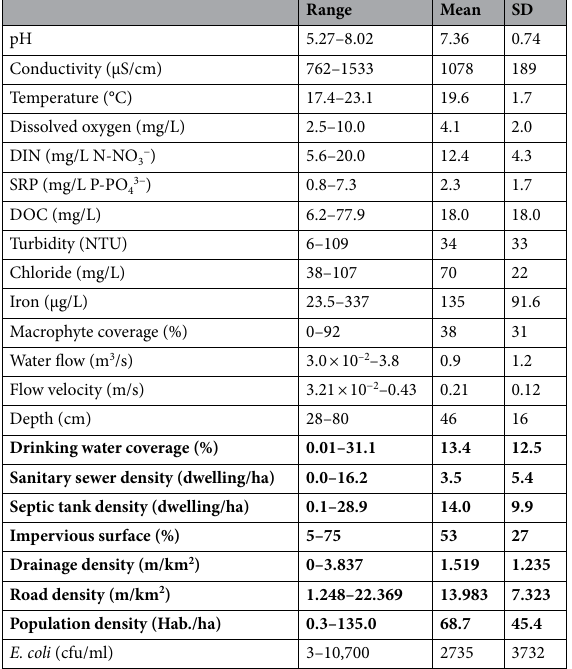
Table 1. Basic statistical summary of environmental (unbolded) and urban infrastructure measured parameters (bolded). DIN, dissolved inorganic nitrogen; SRP, soluble reactive phosphorus; DOC, dissolved organic carbon; SD , standard